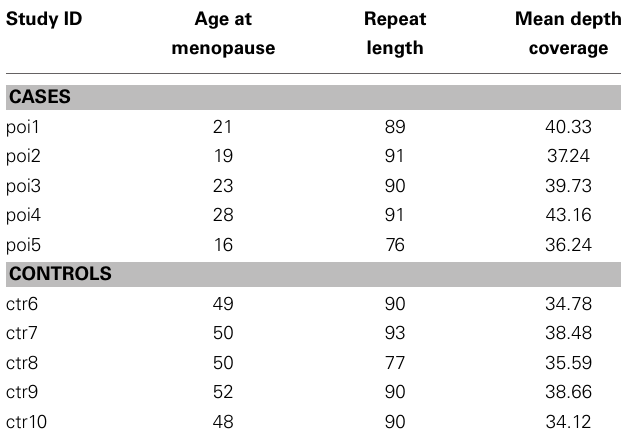
Table 6 | Study sample for WGS variant